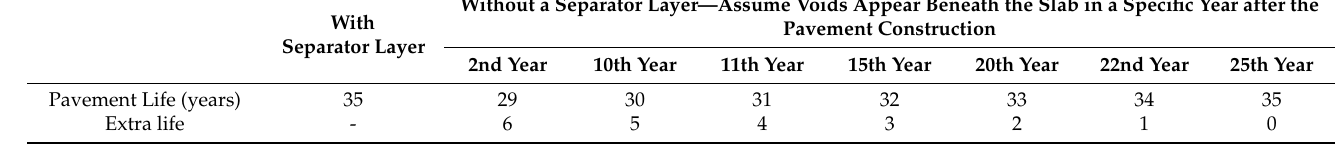
Table 9. Fatigue life increase of pavement because of the composite separator layer. With Separator